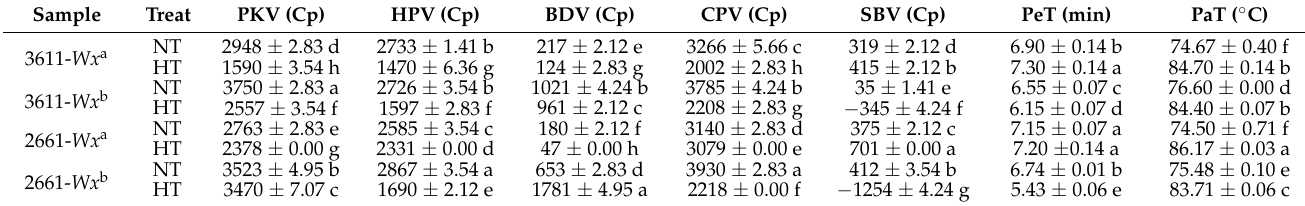
Table 1. RVA analysis of different Wx NILs planted under different temperature conditions.